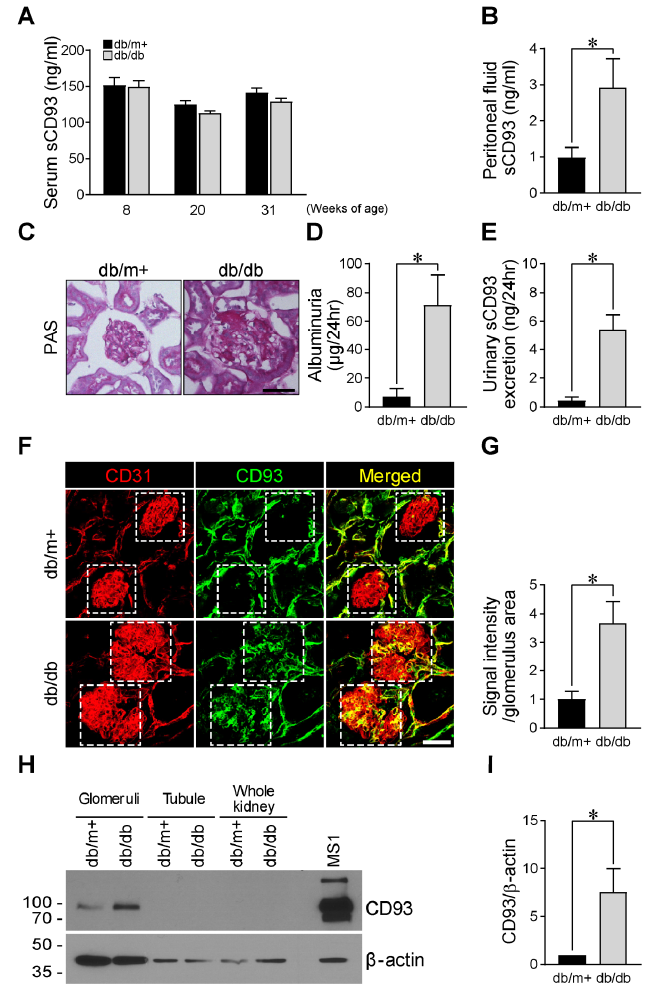
Figure 3. sCD93 in peritoneal lavage fluid and urine, and its expression in the glomeruli of the db / db mice. ( A , B ) The level of serum sCD93 at age 8, 20, and 31 weeks of age (n = 4 per group) ( A ) and the sCD93 of the peritoneal lavage fluid (n = 5~7 per group) ( B ) were measured by ELISA. ( C – G ) The kidney and urine samples of 31-week-old db / db mice were analyzed for the CD93 expression and sCD93